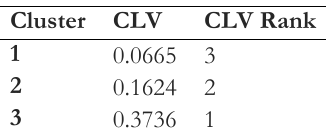
Table 8. Calculating of CLV.